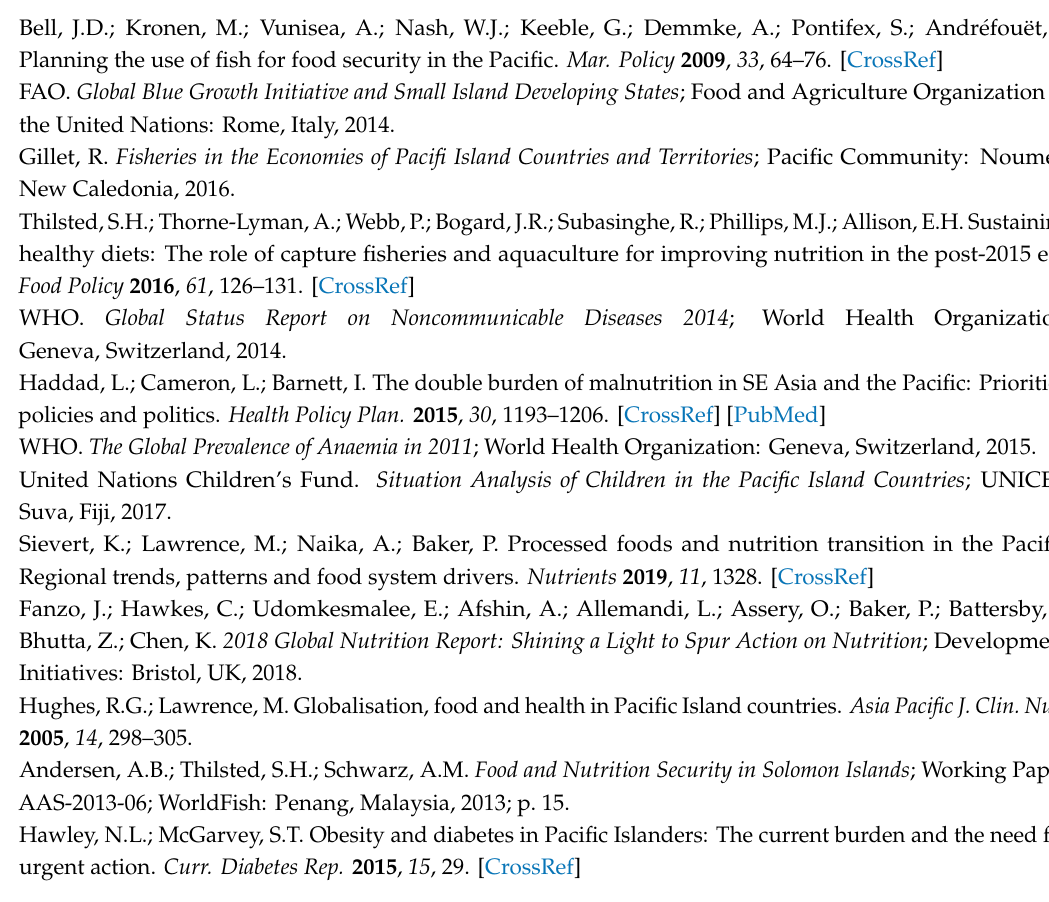
Table S1: Nutritional composition of aquatic foods consumed in the